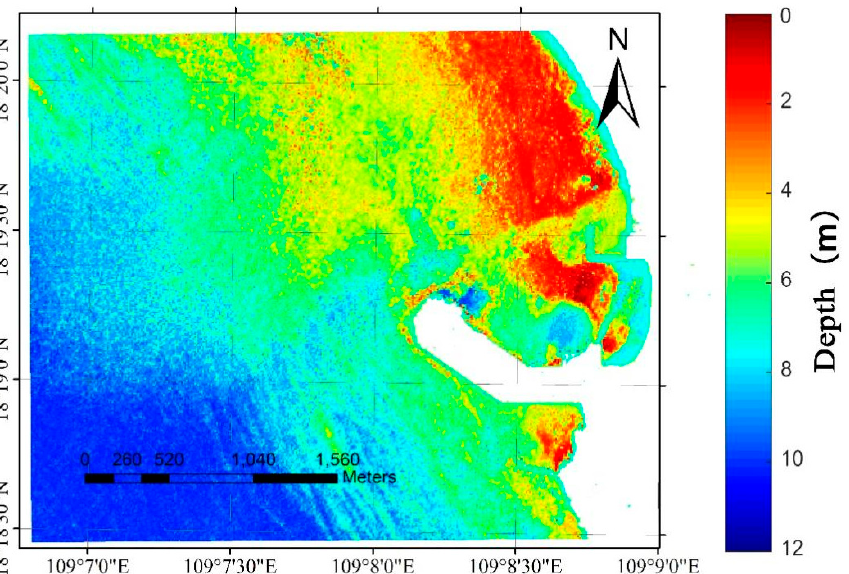
Figure 5. The water depth map estimated based on multiple training sets of satellite image data and neural networks (NN).